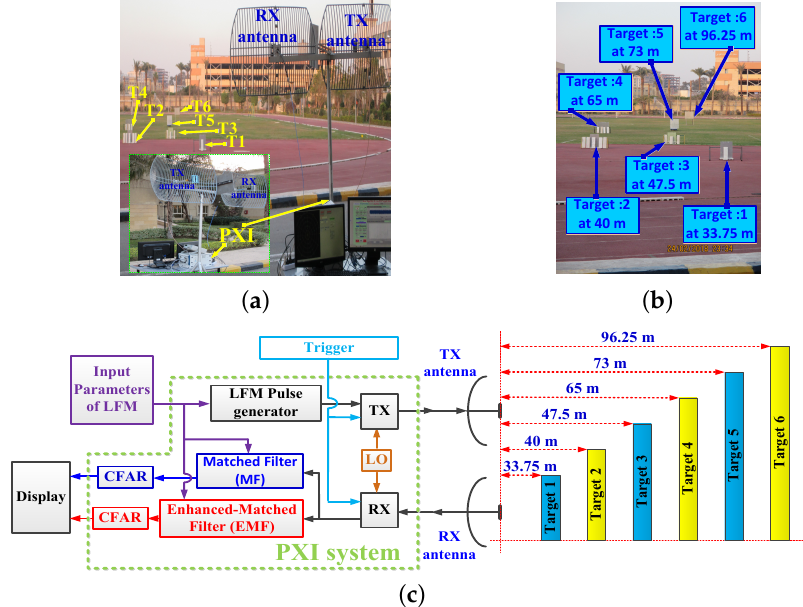
Figure 22. The open field experiment’s results: ( a ) Experimental setup. ( b ) Target locations. ( c ) Block diagram of the experiment setup.